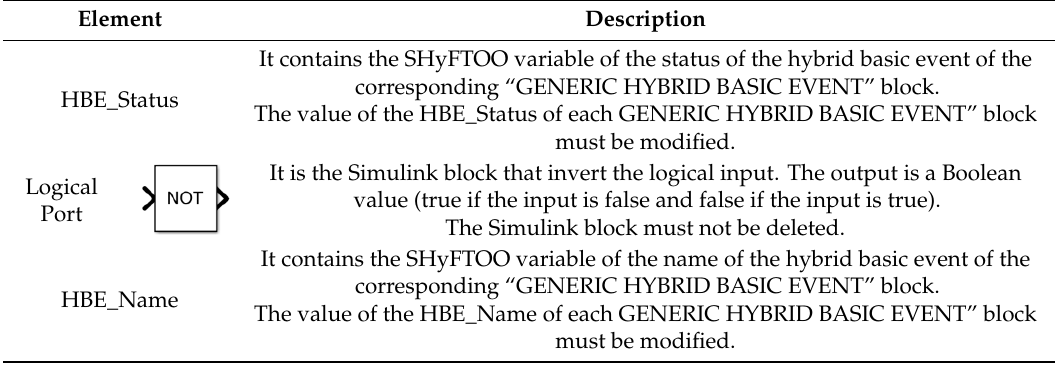
Figure A4. Customization of a Simulink block of type Constant. Table A3. Marking of the components of the GENERIC HYBRID BASIC EVENT Simulink block.